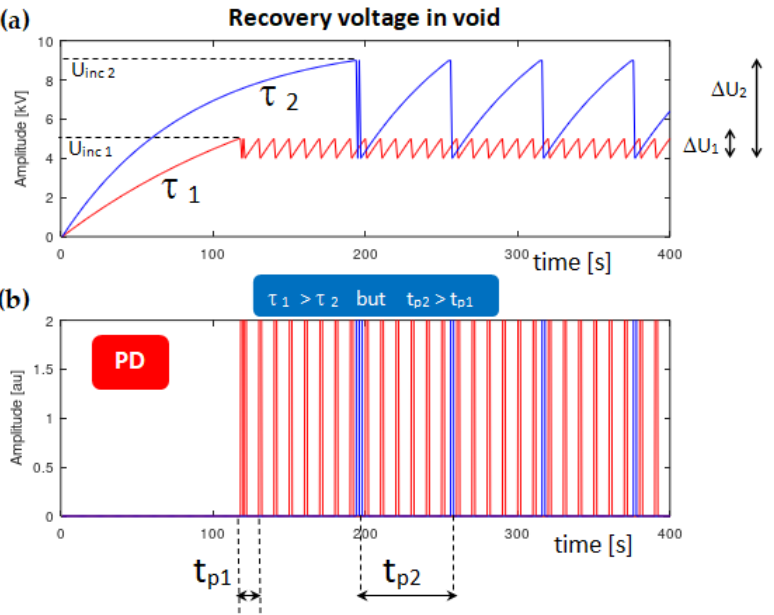
Figure 11. Influence of cavity thickness (1.3 mm—red, 2.3 mm—blue) on recovery voltage build up and time t p between consecutive PD pulses, ( a ) cavity charging voltage, ( b ) PD pulses ( U ext = 4 kV).